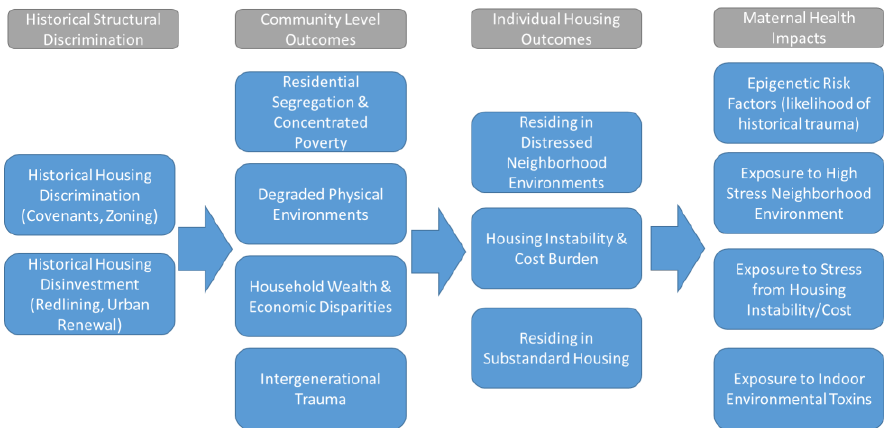
Figure 3. Influence of historical forms of housing discrimination on contemporary community and health outcomes.